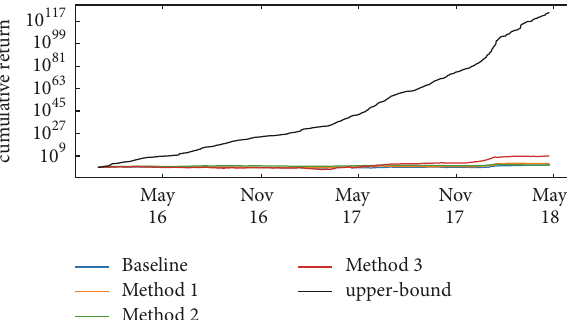
Figure 13: Upper bound for the cumulative return. The cumulative return obtained by investing every day in the currency with highest return on the following day (black line). The cumulative return obtained with the baseline (blue line), Method 1 (orange line), Method 2 (green line), and Method 3 (red line). Results are shown in